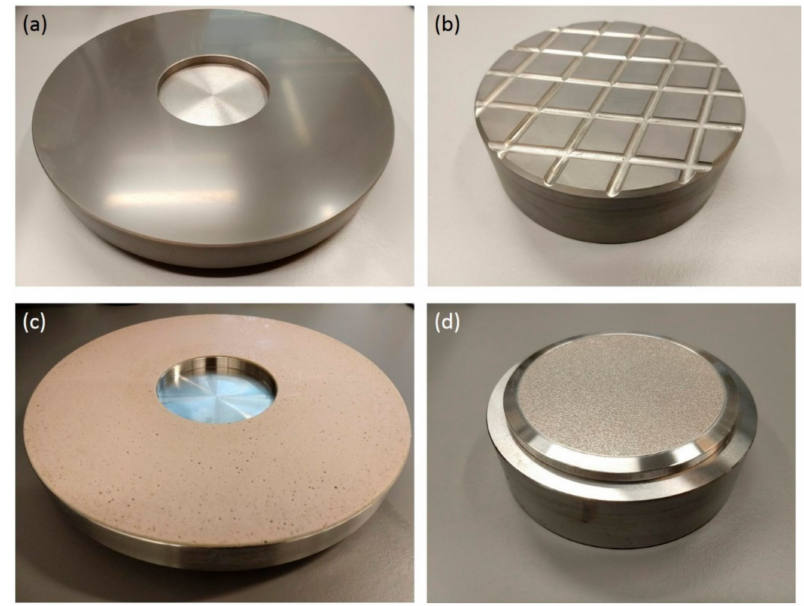
Figure 6. ( a ) Cast iron disk (Ø 30 cm) and ( b ) cast iron conditioning block (Ø 12.7 cm), both dedicated for medium lapping. ( c ) Polyurethane disk (Ø 30 cm) and ( d ) diamond conditioning block (200 µ m diamond pellets, Ø 12.7 cm) both dedicated for polishing with 40 nm SiO 2